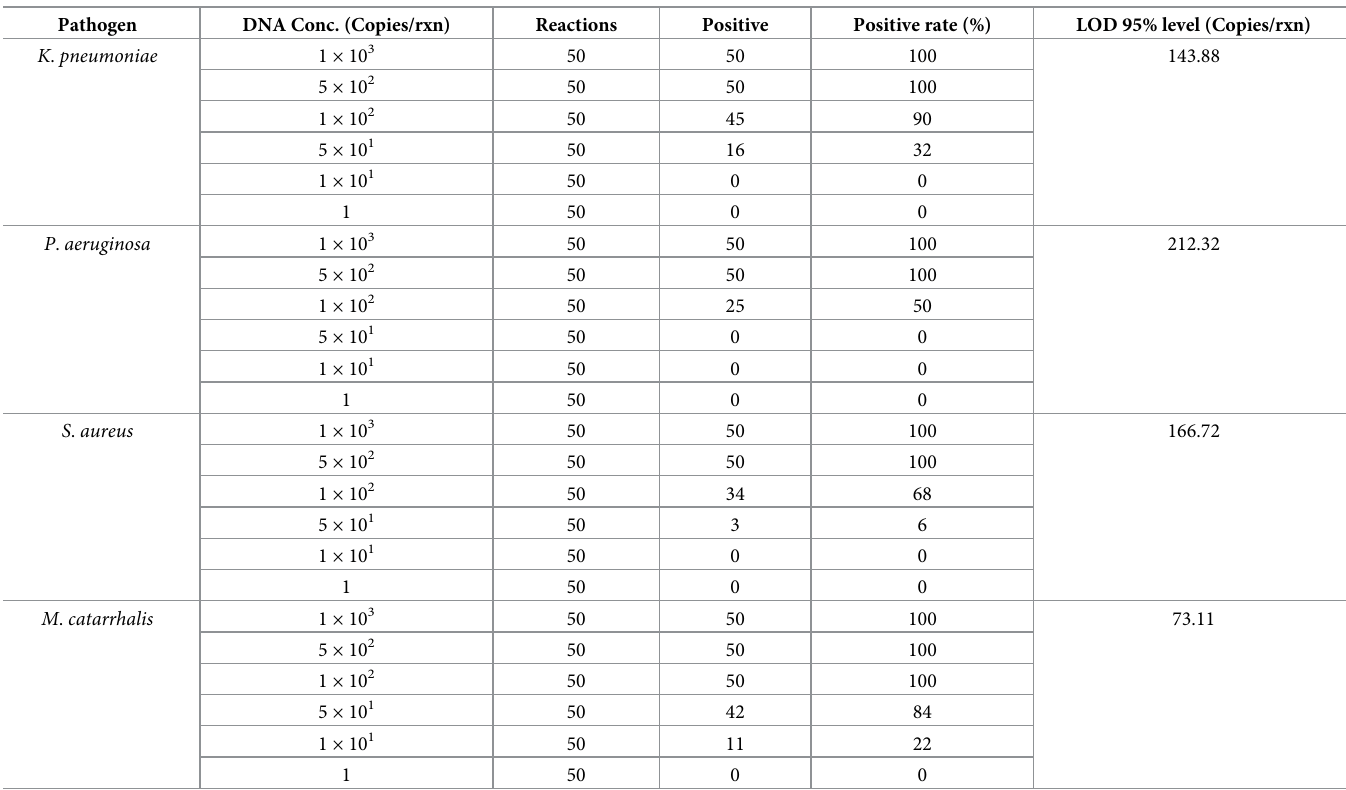
Table 3. Evaluation of detection limit of target pathogens. DNA Conc. (Copies/rxn)